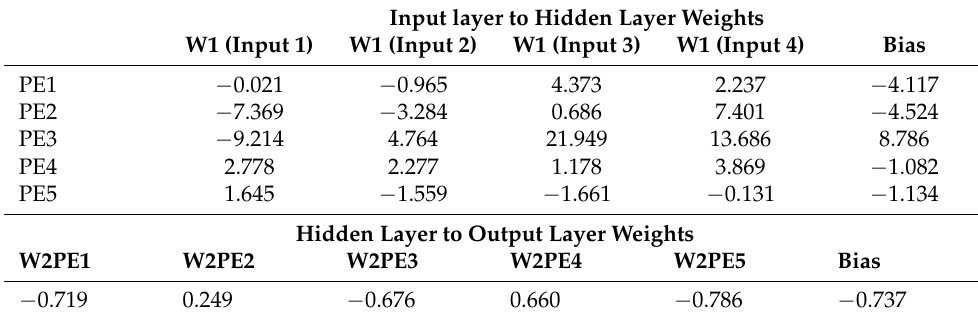
Table 5. The adjustable network parameters.